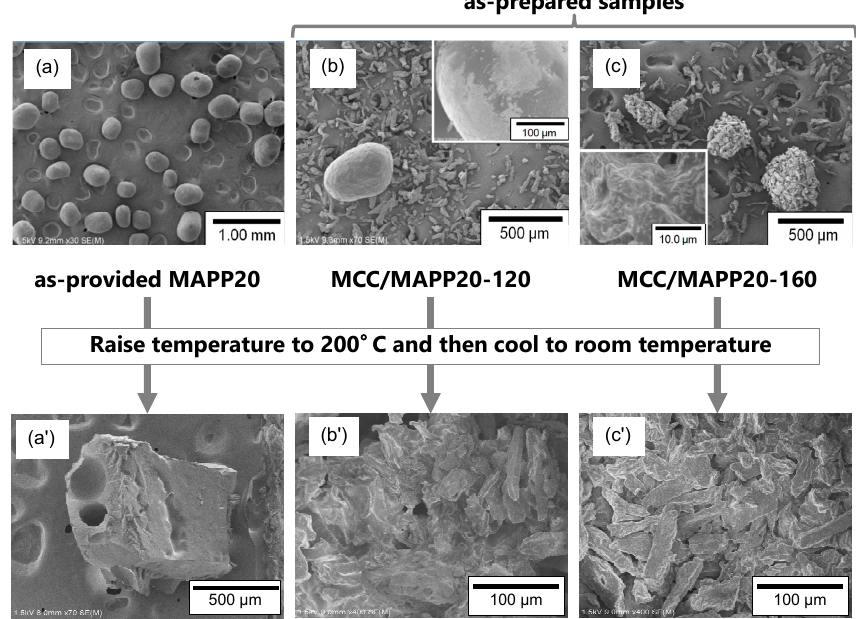
Figure 8. SEM images of ( a ) as-provided MAPP20 and MCC/MAPP20 binary composites prepared at ( b ) 120 °C and ( c ) 160 °C. The images with the prime symbol ( ′ ) added to the letters (a, b, and c) show the ones after heating once to 200 °C and then cooling to room temperature.